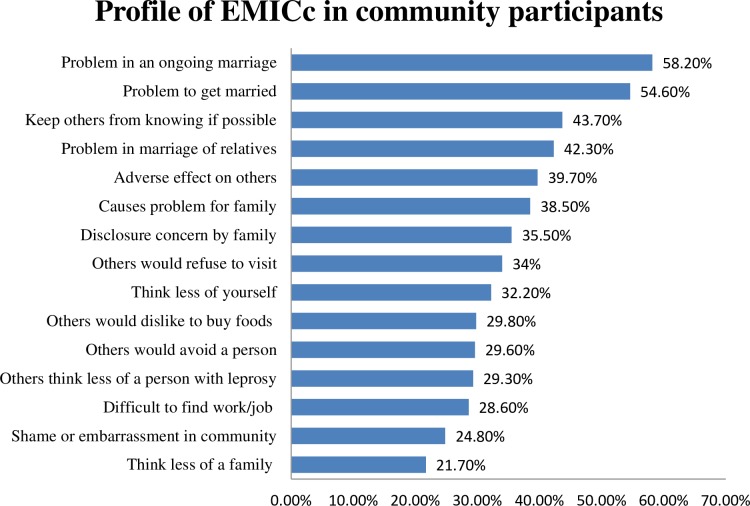
Statement wise stigma statement with percentage answering “Yes”.